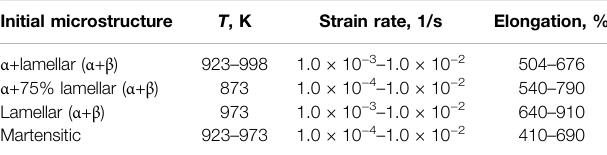
TABLE 2 | Summary of experimental parameters and elongations in the Ti-6Al-4V alloy processed by HPT (Sergueeva et al., 2000; Sergueeva et al., 2002; Shahmir et al.,